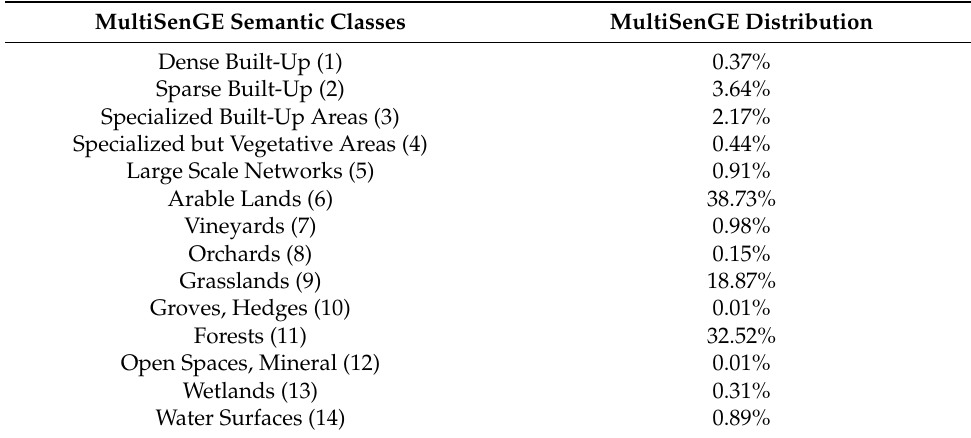
Table 2. Semantic classes distribution for MultiSenGE